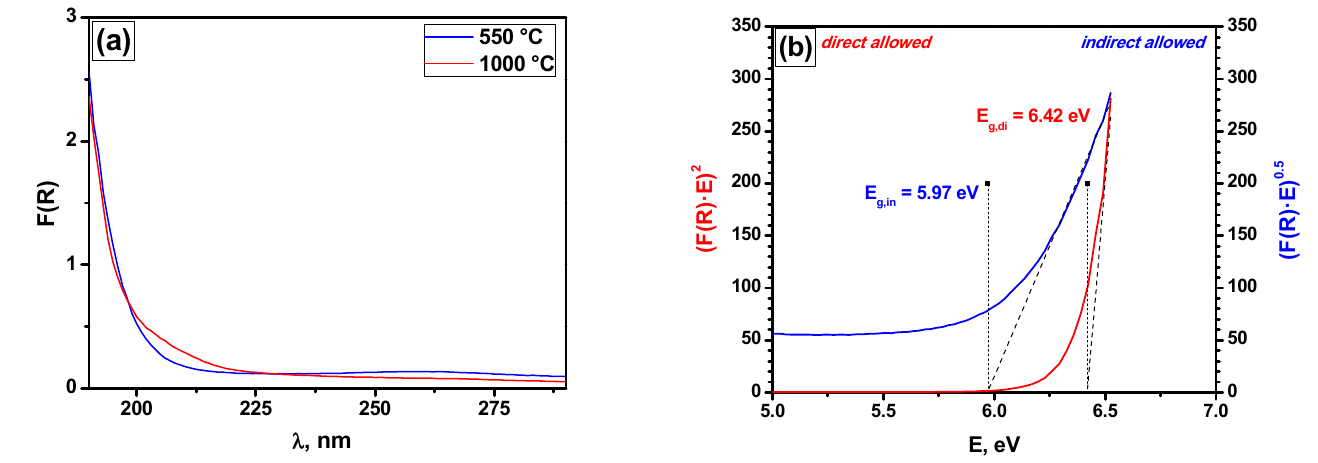
Figure 7. Diffuse reflectance UV–Vis spectra of the C12A7 sample calcined at 550 and 1000 °C ( a ) and dependencies of ( F(R)·E ) 2 and ( F(R)·E ) 0.5 on the photon energy E characterizing the band-gap E g values for direct and indirect allowed transitions for C12A7 ( b ).